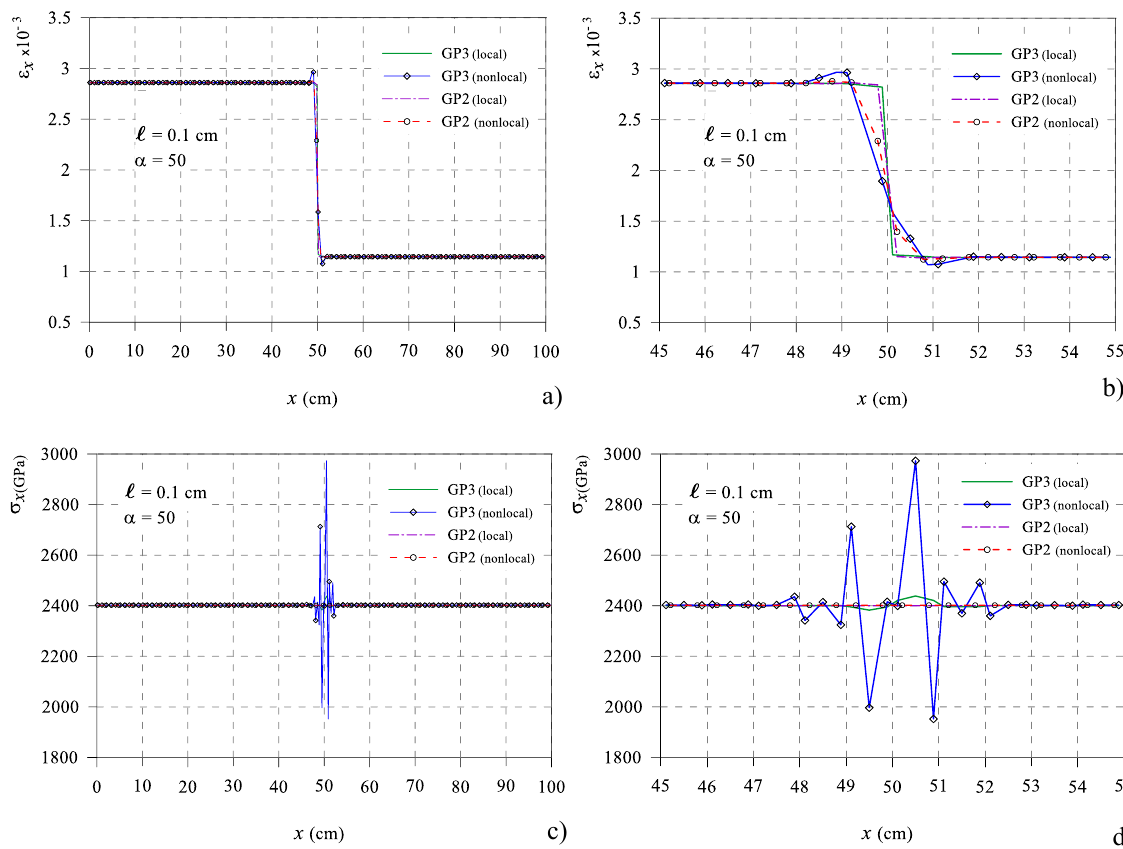
Figure 2: Local and nonlocal solution obtained with full (GP3 curves) and reduced (GP2 curves) integration for the bar of Figure 1 with inter- nal length ℓ = 0.1 : a ) and b ) strain ε